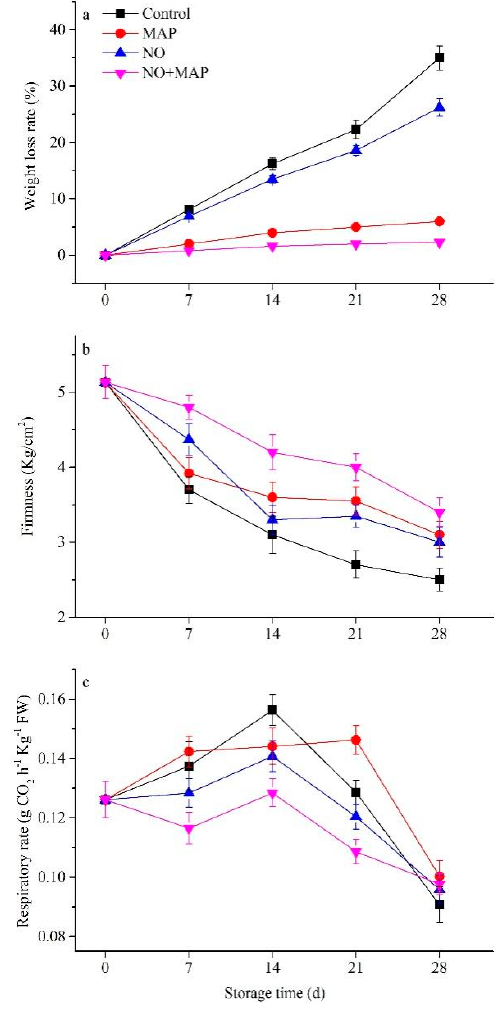
Figure 2. Effects of NO and MAP treatment on weight loss ( a ), firmness ( b ), and respiratory rate ( c ) in water bamboo shoots stored at 4 °C for 0, 7, 14, 21, and 28 d. Values are presented as mean ± SD.